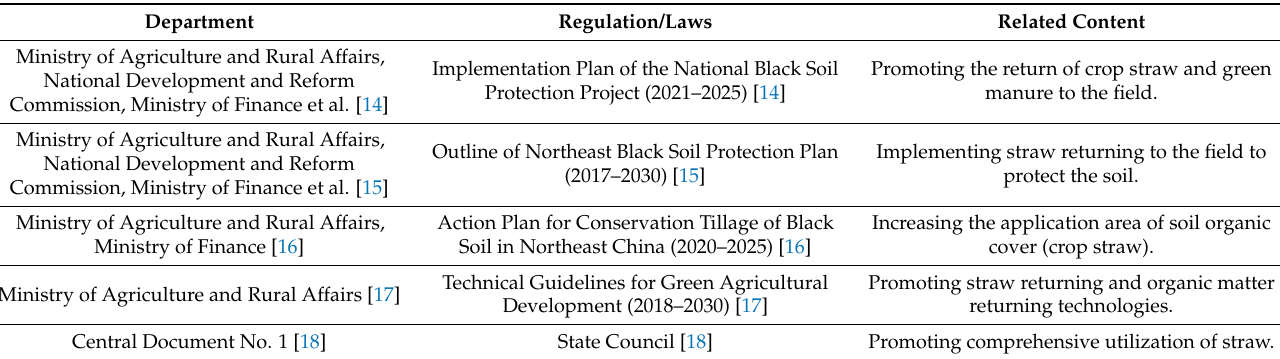
Table 1. Relevant development regulations of straw management technology in